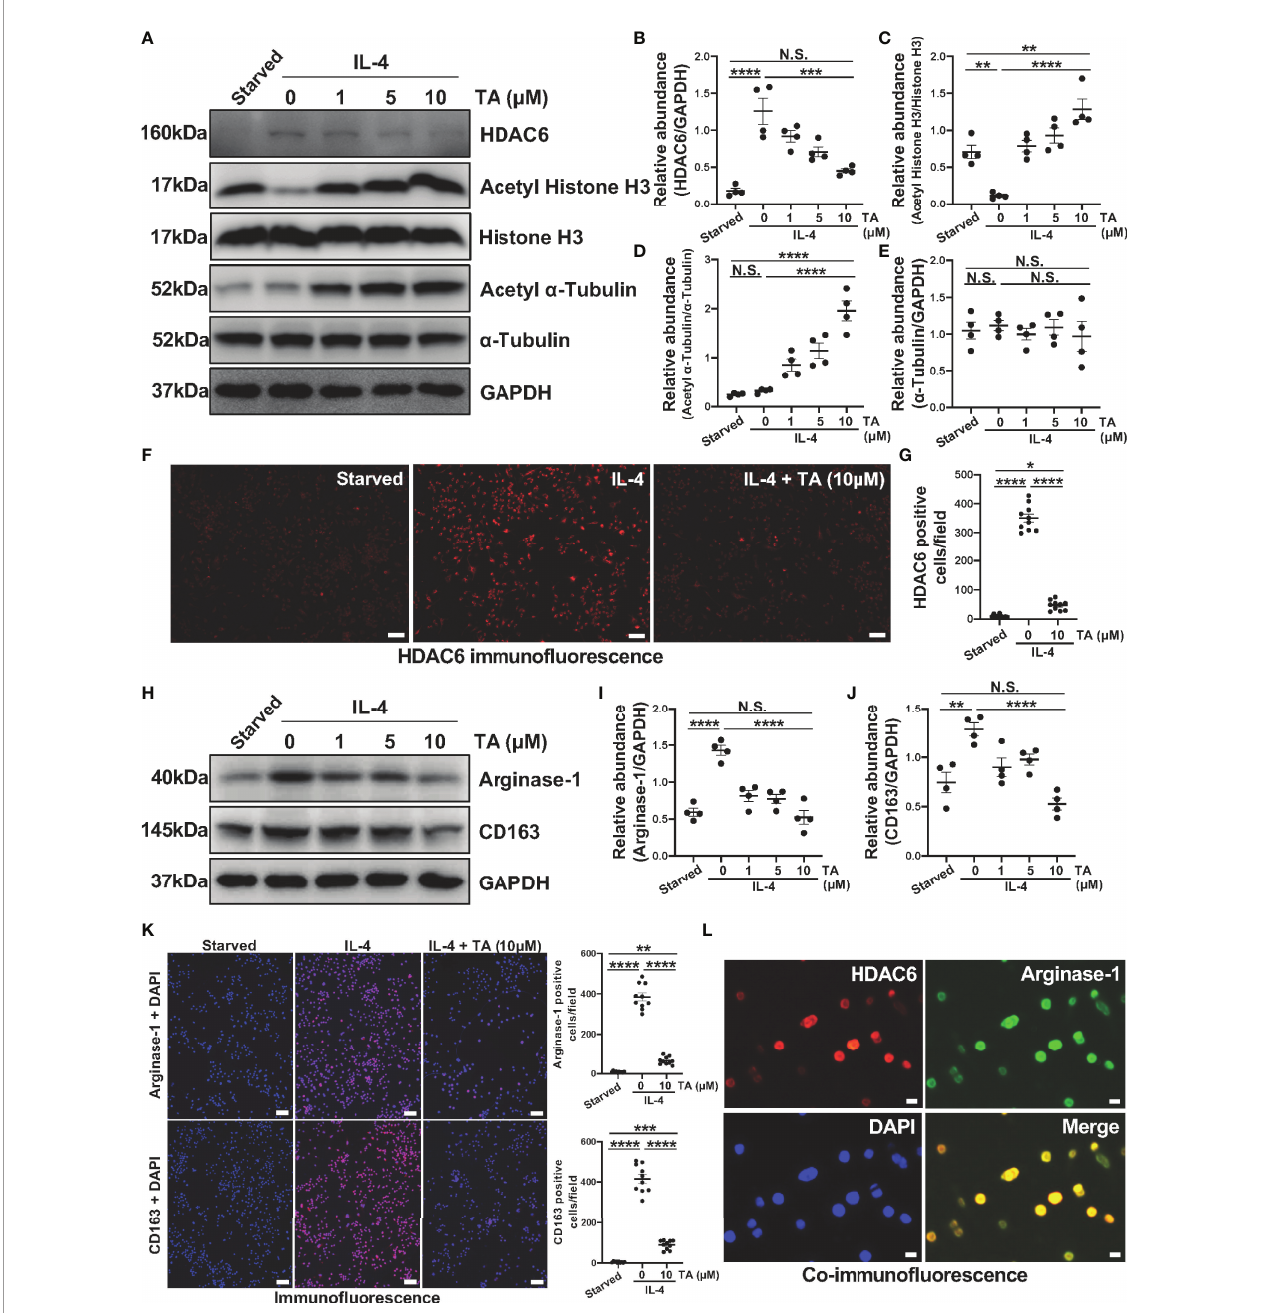
FIGURE 6 | TA inhibits M2 macrophage polarization in IL-4-stimulated Raw264.7 cells. (A) Western blot analysis showed the levels of HDAC6, Acetyl Histone H3, Histone H3, Acetyl a -Tubulin, a -Tubulin, and GAPDH in IL-4-stimulated Raw264.7 cells treated with different doses of TA. Expression levels of (B) HDAC6, (C) Acetyl Histone H3, (D) Acetyl a -Tubulin, and (E) a -Tubulin in different groups were quanti fi ed by densitometry and normalized with GAPDH, Histone H3, and a -Tubulin respectively. (F) Representative micrographs of immuno fl uorescence staining of HDAC6 in Raw264.7 cells with different treatments (Scale bars = 50 m m). (G) Quantization count of HDAC6-positive cells was calculated. (H) Western blot analysis showed the levels of Arginase-1, CD163, and GAPDH in IL-4- stimulated Raw264.7 cells treated with different doses of TA. Expression levels of (I) Arginase-1, and (J) CD163 in different groups were quanti fi ed by densitometry and normalized with GAPDH. (K) Representative micrographs of immuno fl uorescence staining of Arginase-1 and CD163 in Raw264.7 cells with different treatments, and quantization count of Arginase-1 and CD163 positive cells (Scale bars = 50 m m). (L) Co-immuno fl uorescence staining of HDAC6 (red) and Arginase-1 (green) in the Raw264.7 cells (Scale bars = 10 m m). Data were expressed as means ± SEM. *P<0.05, **P<0.01, ***P<0.001, ****P<0.0001. NS: P ≥